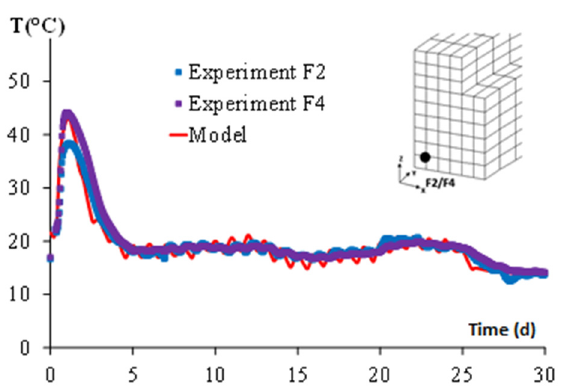
Figure 20. Temperature obtained by the model on outer face on the gusset.